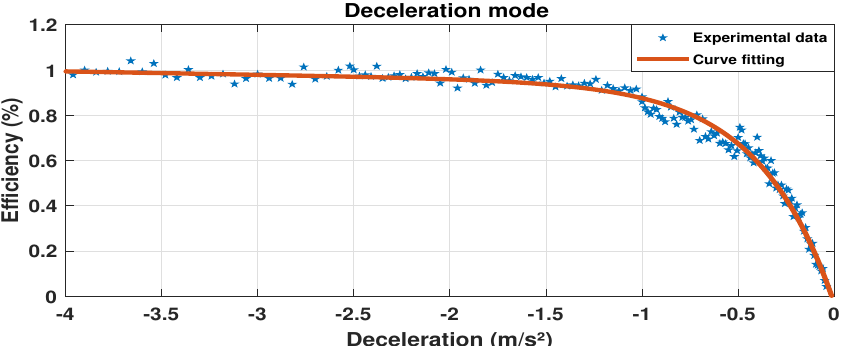
Figure 14. Variation in the instantaneous regenerative braking efficiency as a function of the decelera- tion level.